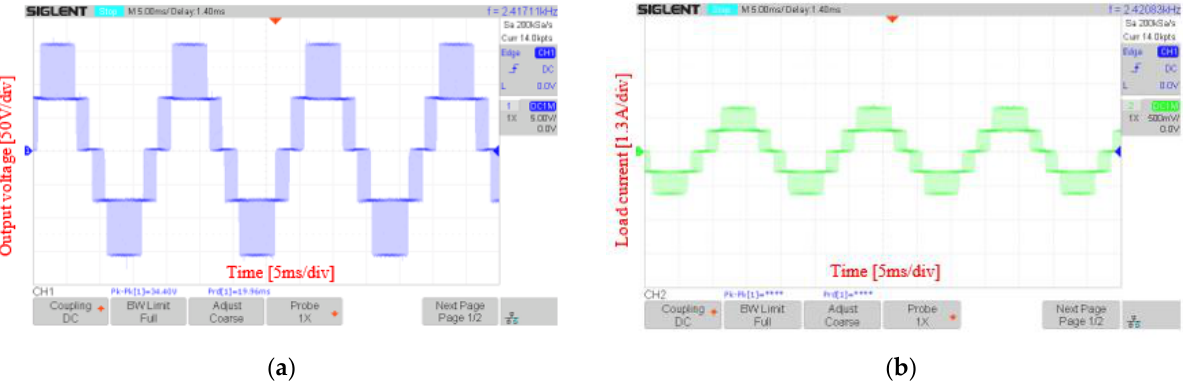
Figure 43. Experimental result of four level-shifted carriers using DSA-LSC method, ( a ) output voltage; ( b ) output current.